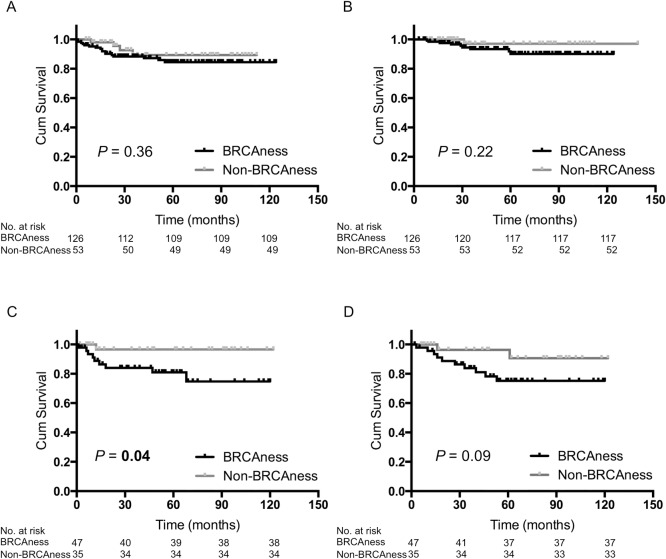
Kaplan–Meier analysis of patients with BRCAness tumors versus non-BRCAness tumors.(A) RFS of patients who received adjuvant chemotherapy (n = 179). (B) OS of patients who received adjuvant chemotherapy (n = 179). (C) Recurrence-free survival (RFS) of patients who received no treatment (n = 82). (D) Overall survival (OS) of patients who received no treatment (n = 82).